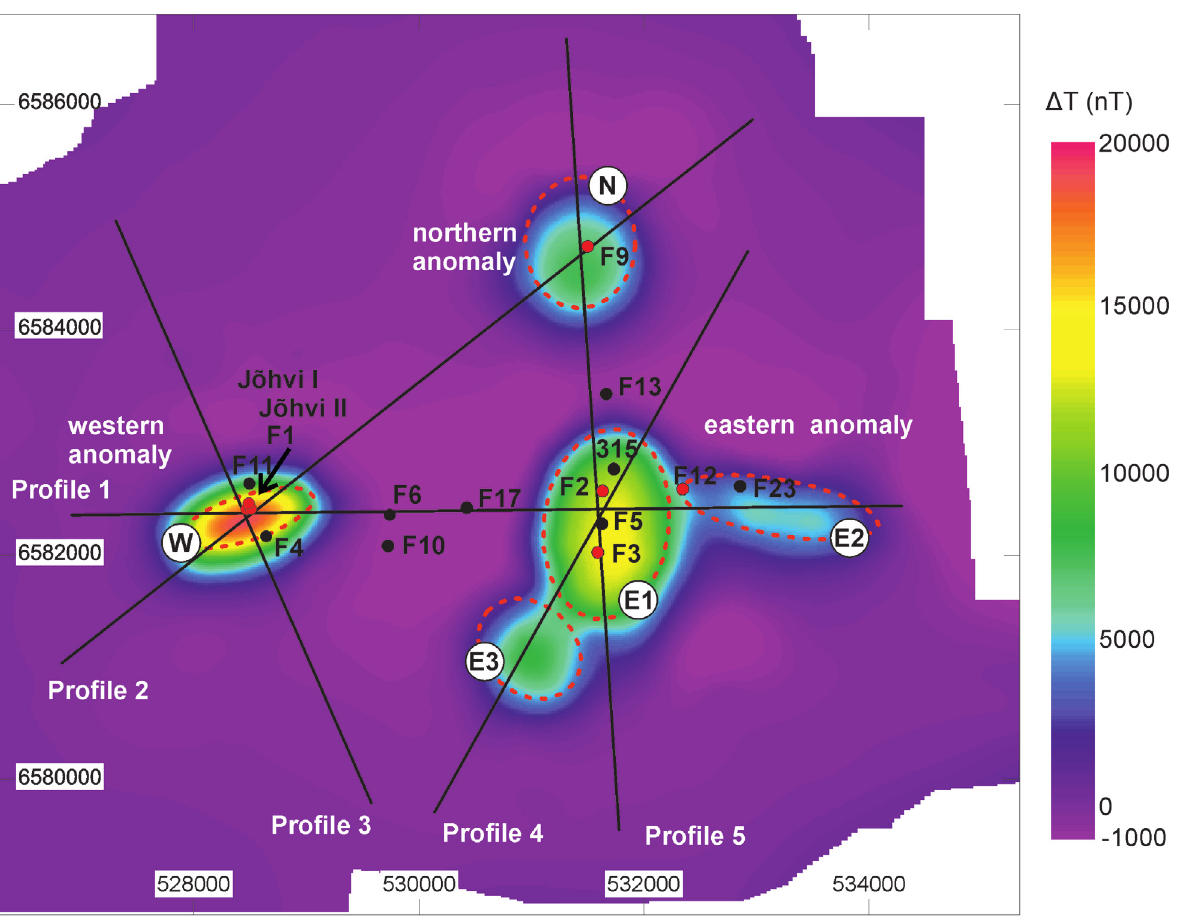
Fig. 4. Magnetic field calculated by five elliptic cylinders (red dashed lines) to simulate the Jõhvi anomaly by model. Shown are the profiles for the magnetic modelling and locations of drill holes. Red colour indicates the holes where Mt­gneiss has been discovered. Coordinates are in the UTM zone